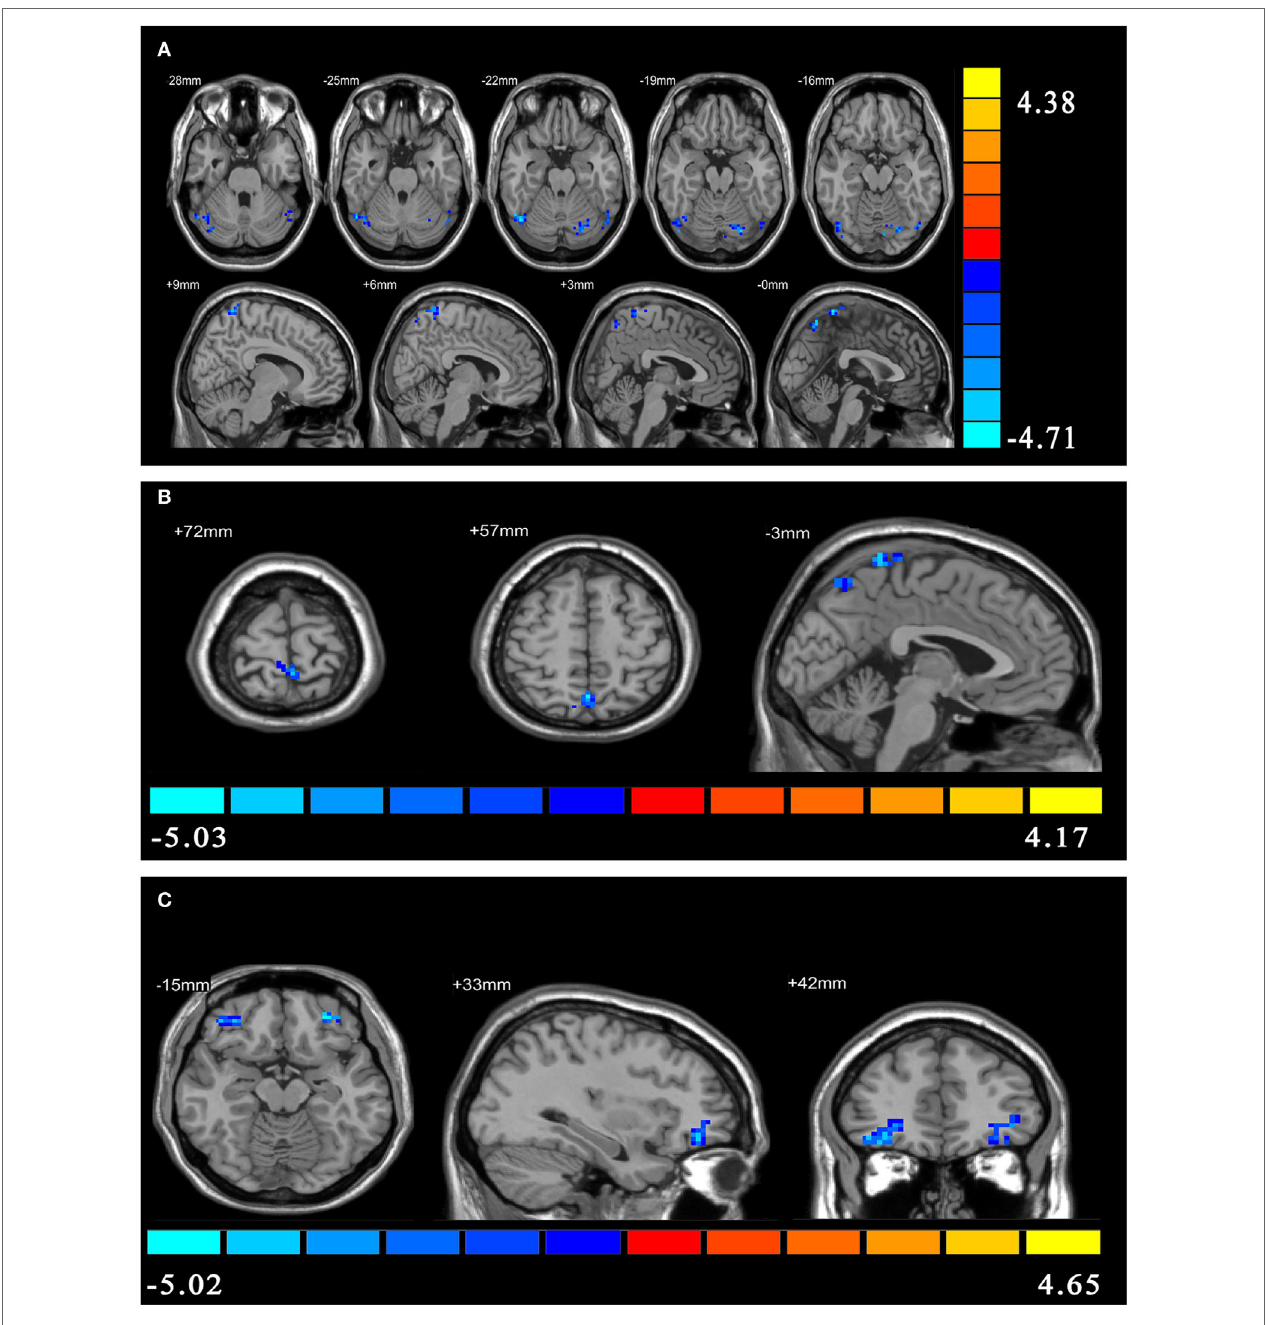
FigUre 1 | The between-group differences in effective connectivity. (a) The between-group differences in effective connectivity from ventral right anterior insula (rAI) to the whole brain. (b) The between-group differences in effective connectivity from dorsal rAI to the whole brain. (c) The between-group differences in effective connectivity from the whole brain to ventral